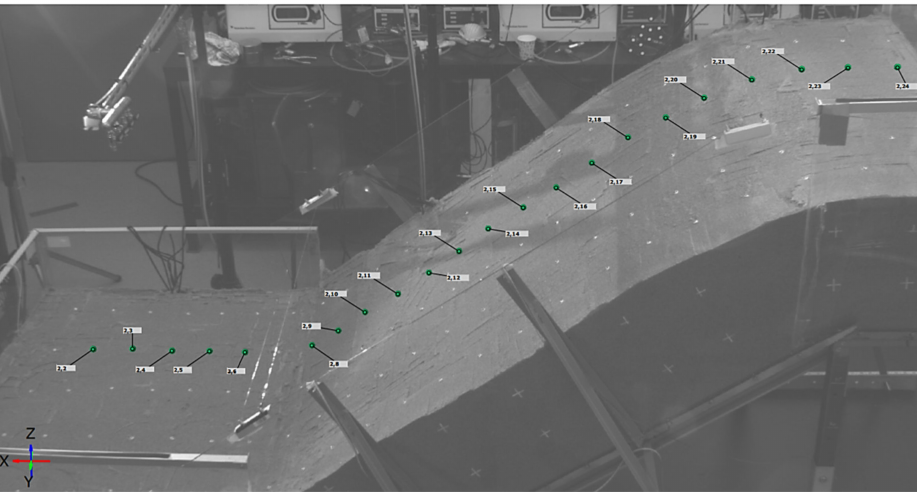
Figure 8. Points of the longitudinal profile [66]. Observed points are linked by lines in a longitudinal profile made of points from the second row (Figure 9). Connecting the points in lines allows for easier follow-up in the next stages of the test. This profile is one of the best examples because almost all points from the second row are visible in the undeformed reference stage (Stage 1) shown in Figure 9. Point 2,1 was not recorded by the left camera, and point 2,7 was not visible due to the tensioned wire placed just above the point in the lower part of the model as a protection from buckling of the plexiglass sides.